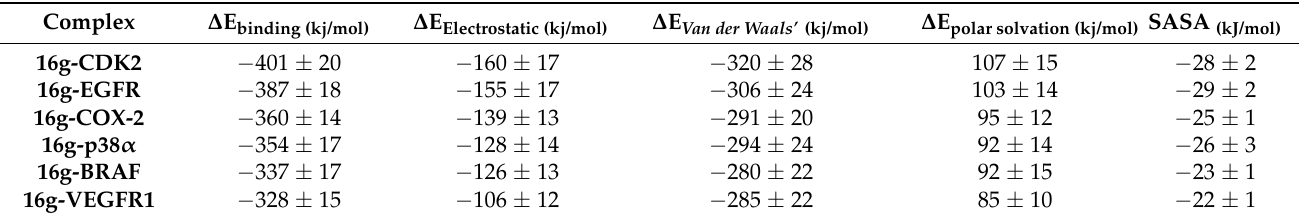
Table 6. MM-PBSA calculations of the binding free energy for the 16g in complex with the six potential targets. Complex ∆ E binding